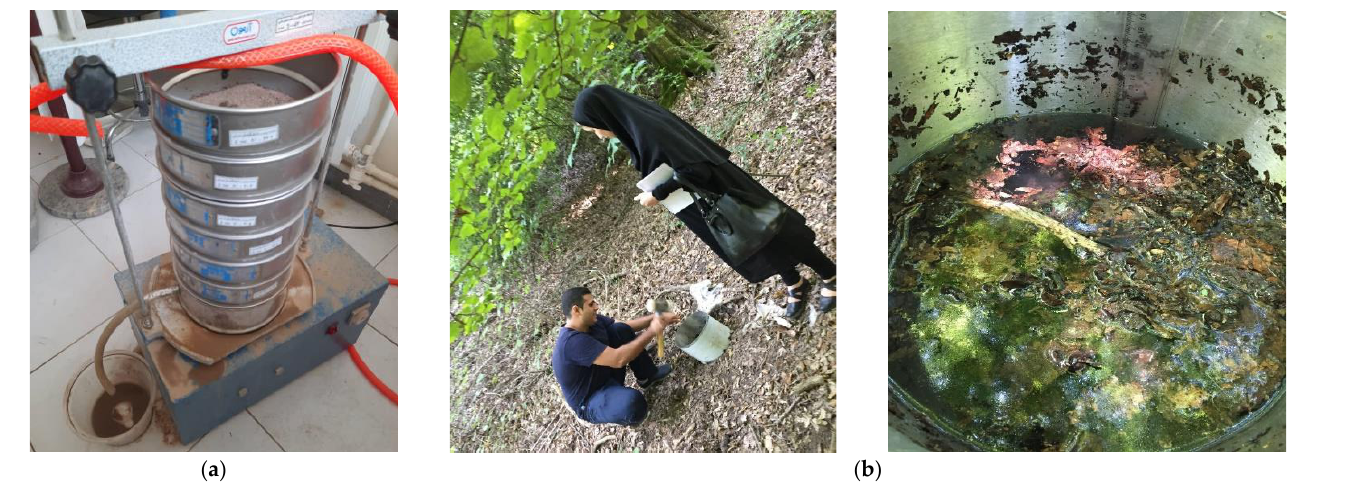
Figure 3. View of laboratory ( a ) and field measurements ( b ).